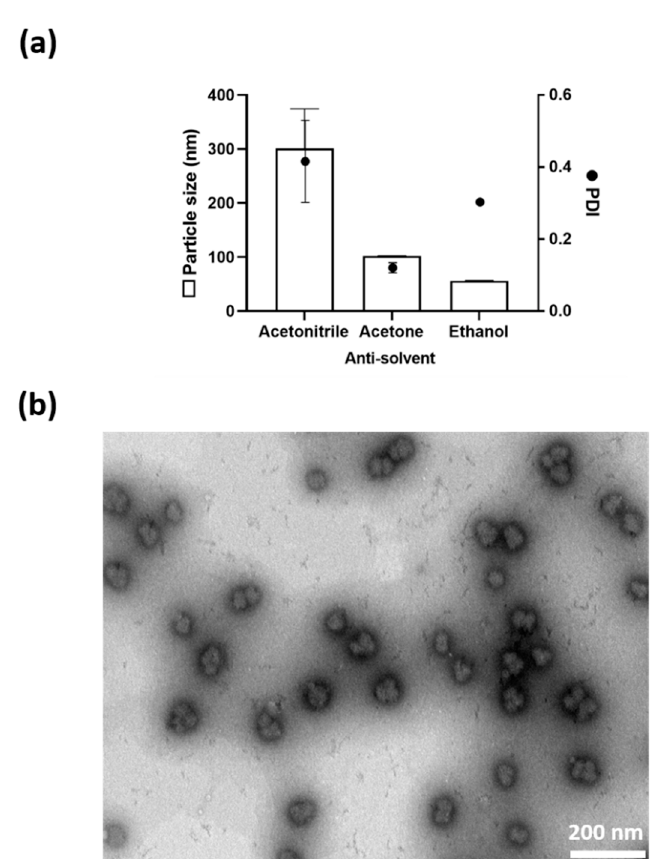
Figure 1. Physical characterization of the amino-dextran nanoparticles. ( a ) Effect of the anti-solvent on the particle size and the PDI of aDNP. ( b ) Transmission electron microscopy photomicrograph of aDNP produced using acetone (×93,000). Scale bar, 200 nm. aDNP: dextran with 50 amines per